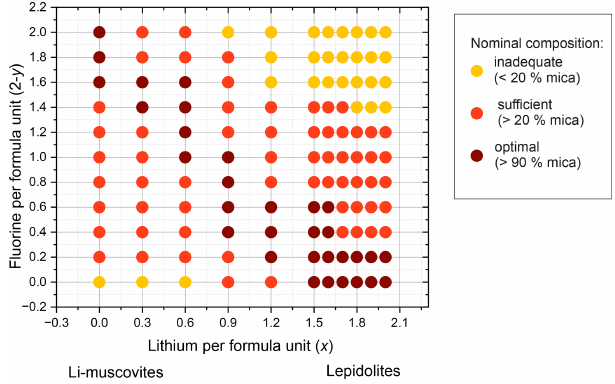
Figure 3. Diagram of phases as determined by X-ray diffraction for compositions along the trilithionite–muscovite (Li-muscovites) and the trilithionite–polylithionite join (lepidolites). Optimal composi- tions of the nominal oxide mixtures are plotted in brown dots, suf- ficient nominal compositions are plotted in red dots and inadequate compositions are displayed in orange